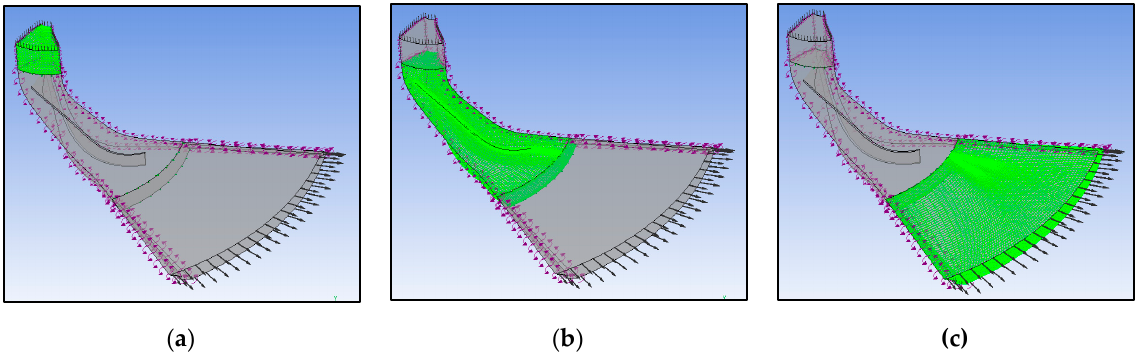
Figure 2. Domain Setup Highlighting the Pre-Impeller ( a ), Impeller ( b ) and Diffuser ( c ).